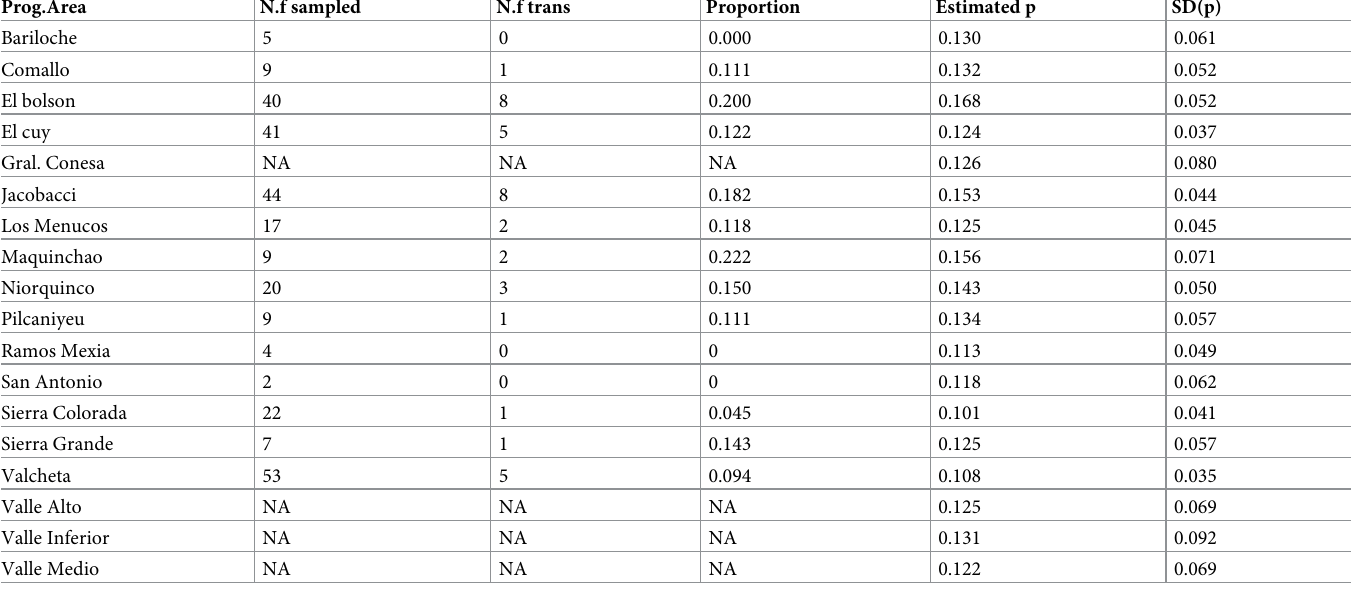
Table 2. Dogs only data 2010. Proportion of farms with recent transmission, estimated probability of a farm having recent transmission, and its standard deviation. Prog.Area N.f sampled N.f